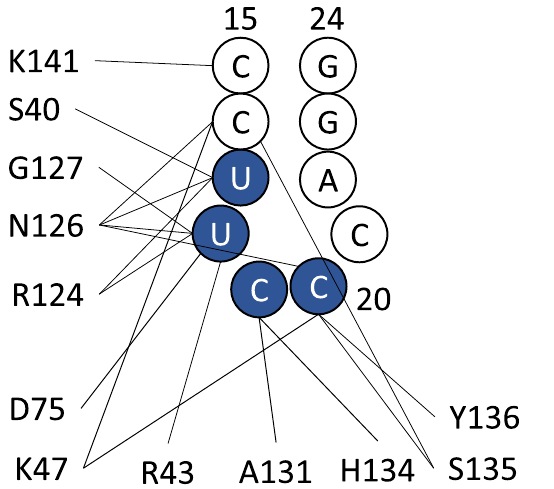
Fig 4. Graphical representation of the hydrogen bond interactions between SL1 and nsp1. Bases of U17 to C20 (colored blue) are recognized by the hydrogen